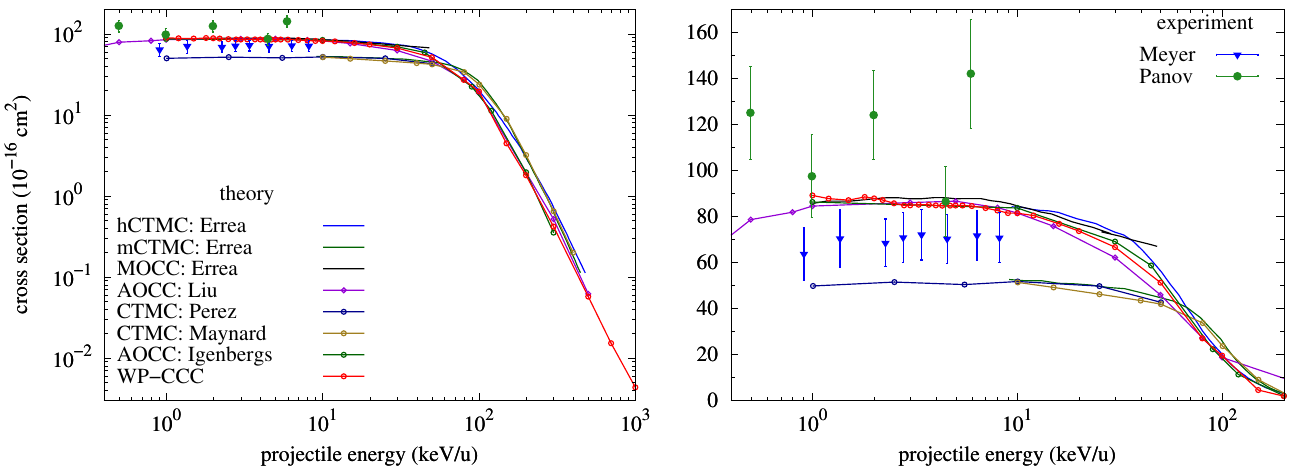
Figure 1. The total cross section for electron capture in Ne 10 + − H(1s) collisions calculated using the WP-CCC method. Experimental measurements are by Panov et al. [6] and Meyer et al. [7]. Also